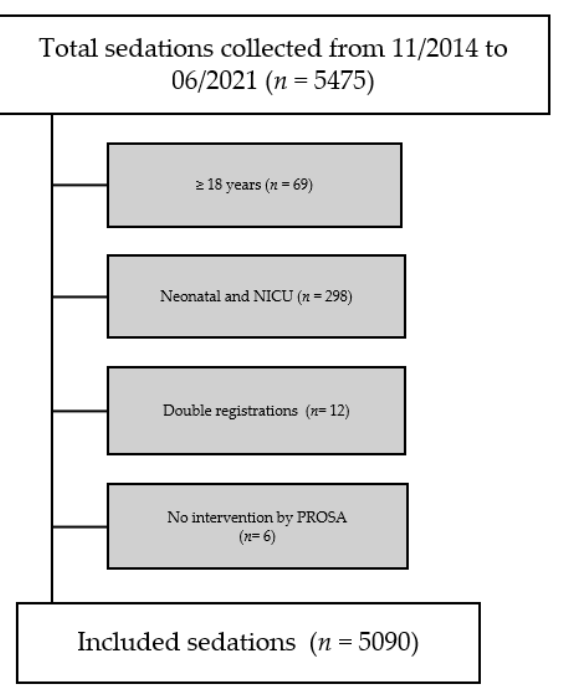
Figure 1. Flowchart of collected data and patient inclusion. Abbreviations in the figure: NICU = Neonatal Intensive Care Unit, PROSA = Procedural Sedation and Analgesia.